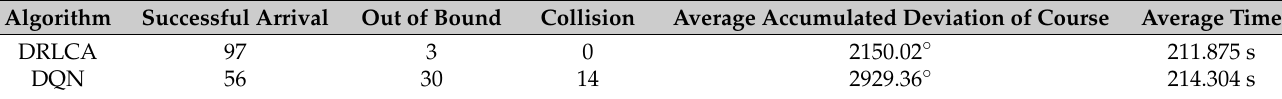
Table 5. Results of 100 times experiments.